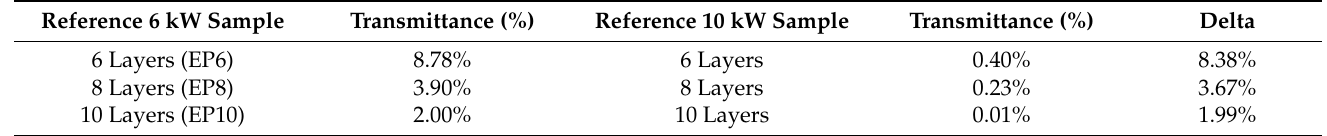
Table 7. Transmittance ratio obtained with 6 kW of power and 10 kW of power.